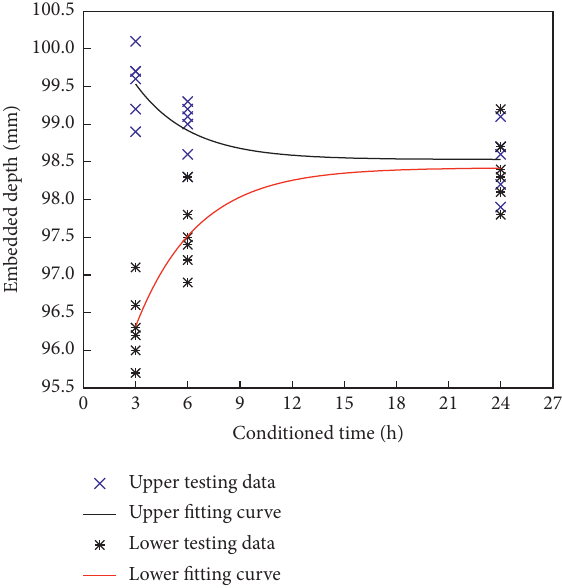
Figure 13: Variation of compactness with interval time.